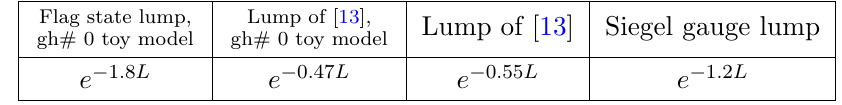
p Table 2 . Rate of decay of lump coe(cid:14)cients at R = 2 3 as a function of level L . their conformal weight, but in (D.2) this only contributes a factor given by the two-point function of plane wave vertex operators, which evaluates to unity. Second, we give